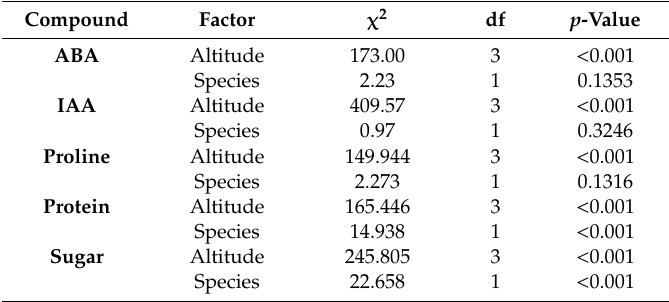
Table 1. Generalized Linear Model (GLM) of plant compounds concentration between plant species and